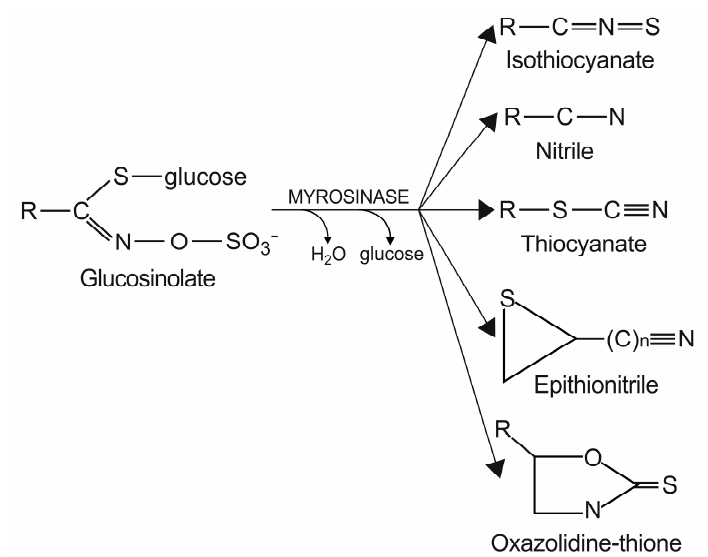
Figure 4. Hydrolysis of glucosinolates catalyzed by myrosinase. Myrosinase catalyzes the hydrolysis of the thioglucoside linkage, thus leading to the formation of different products. R represents the amino-acid-derived side-chain. Table 3. Classification of glucosinolates on the basis of their amino-acid precursor.